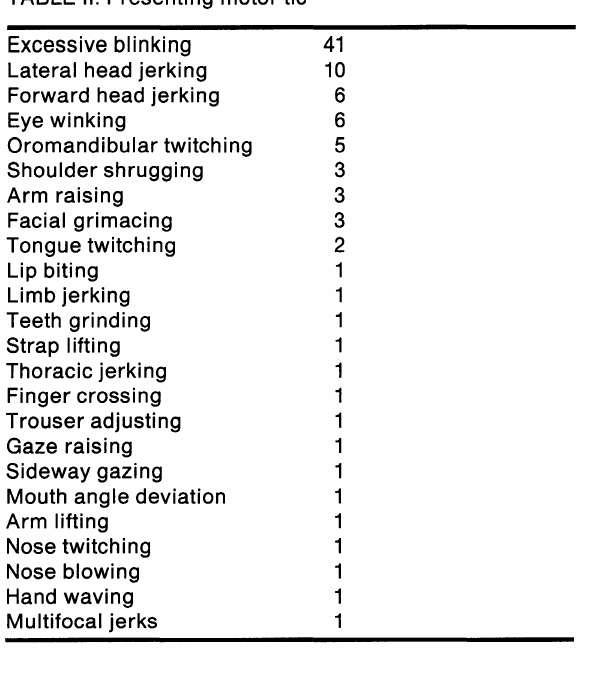
TABLE II. Presenting motor